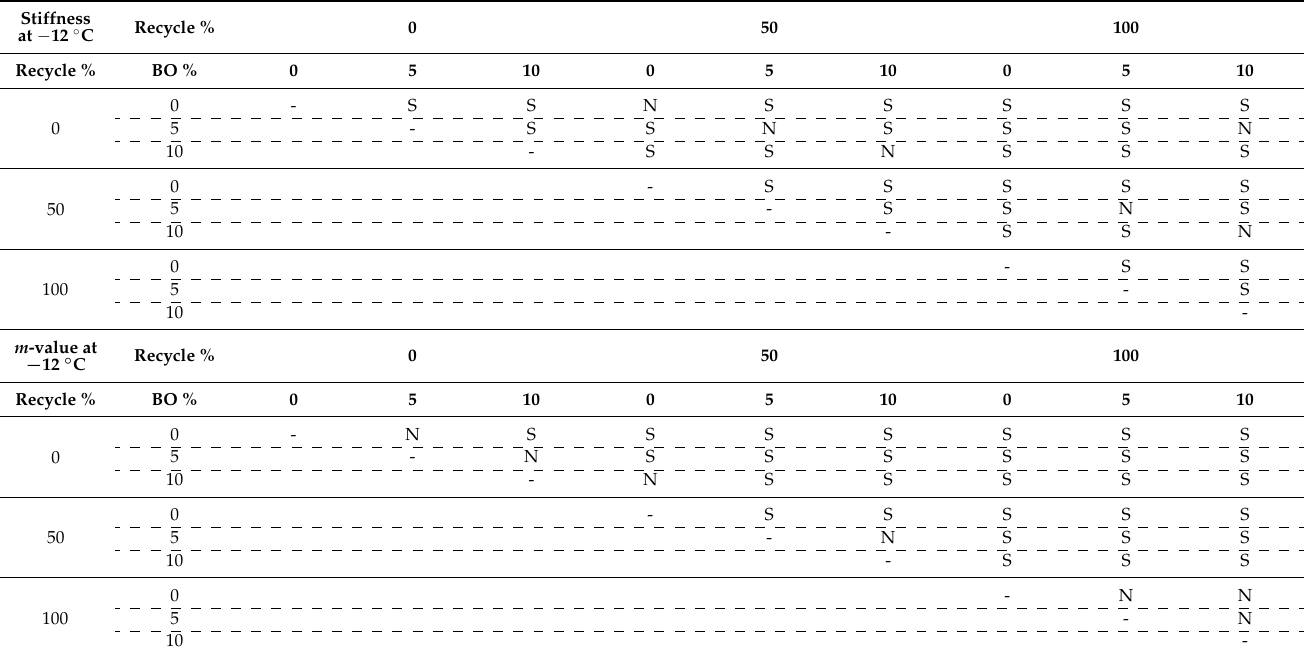
Table 7. Statistical analysis results of the stiffness and m- value for RTFO + PAV as a function of aged binder contents and the addition of base oil at − 12 °C ( α = 0.05).